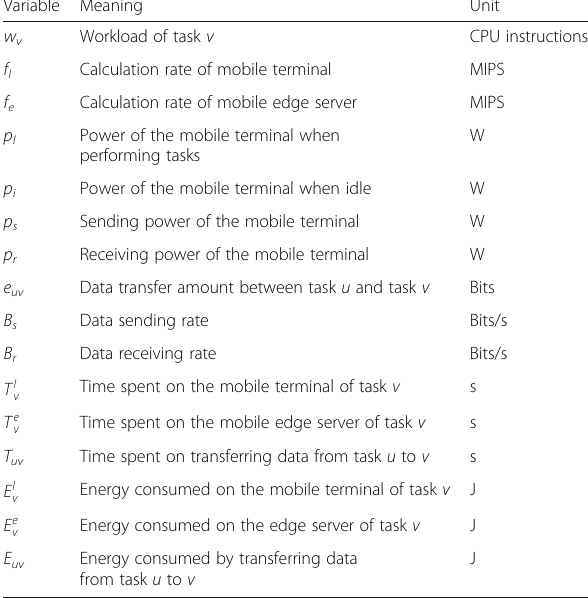
Table 1 Parameter table for energy consumption and time model